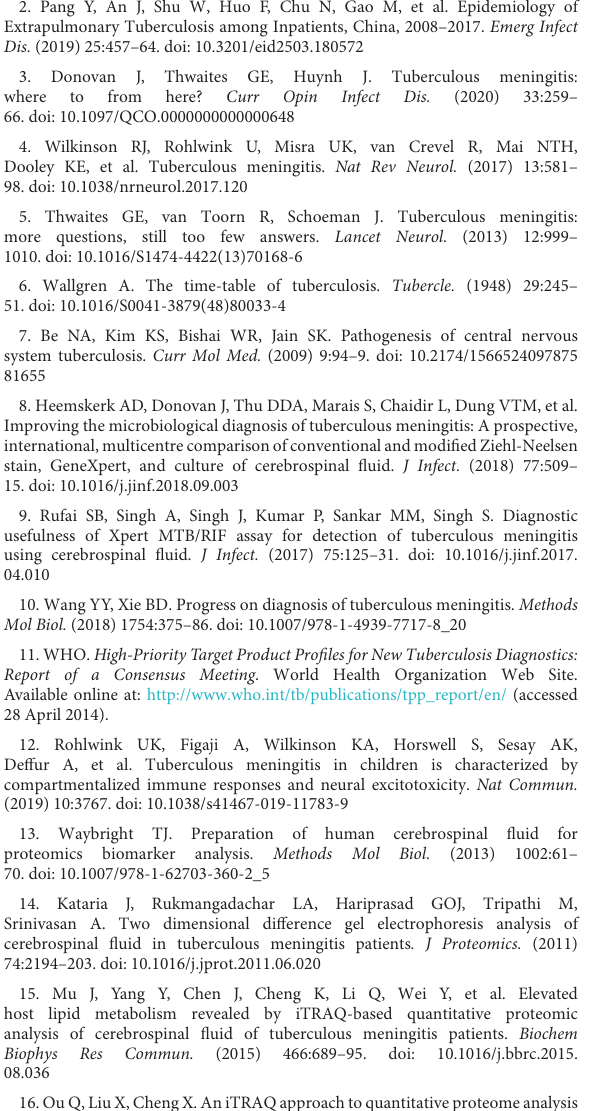
SUPPLEMENTARYFIGURE1 The expression of 8 proteins in CSF between definite and probable TBM patients. SUPPLEMENTARYFIGURE2 The expression of 8 proteins in patients with TBM with different symptom durations.